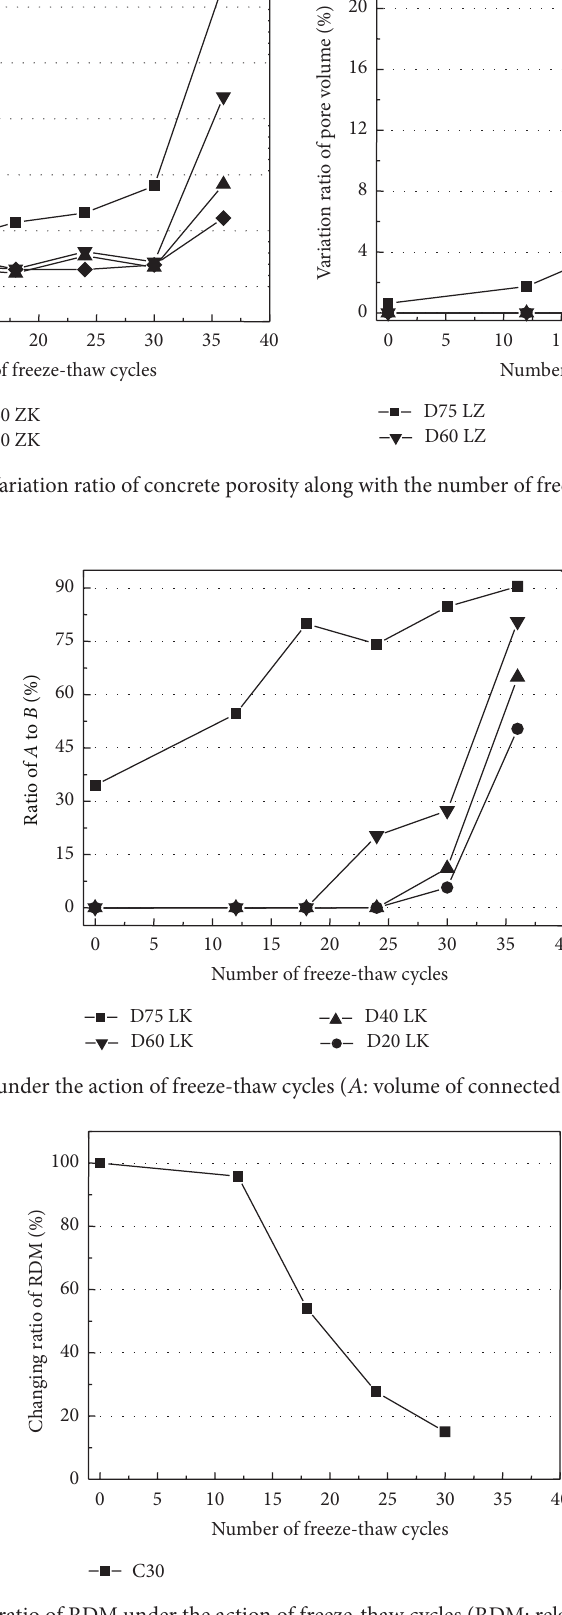
Figure 6: Variation ratio of RDM under the action of freeze-thaw cycles (RDM: relative dynamic